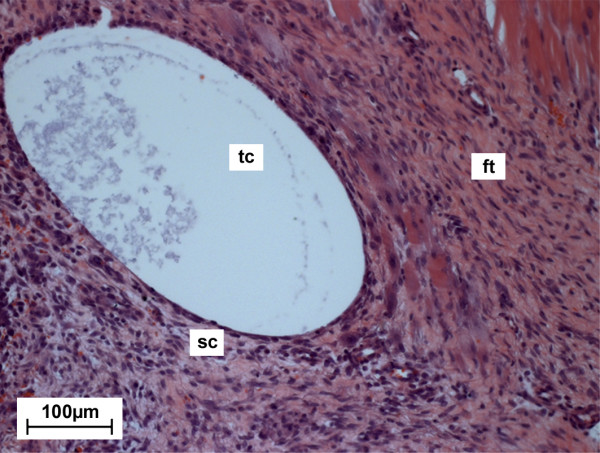
Image section of an MgCa0.8 implant site two weeks postoperatively (H. E., 200×). Within the periimplant fibrous tissue (ft) a tissue cavity (tc) is clearly observable. The tissue cavity is surrounded by a synoviocyte-like cell layer (sc).